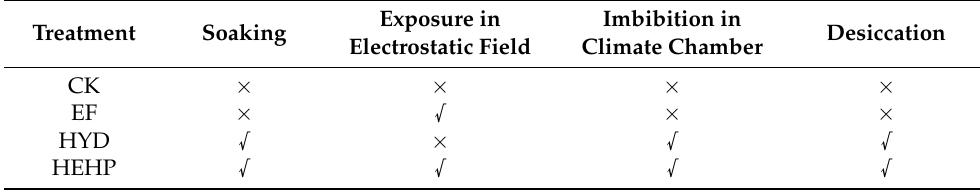
Table 3. Treatment